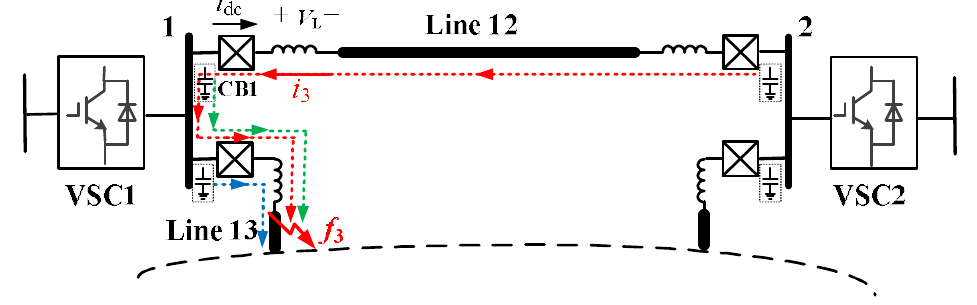
Figure 8. The voltage of inductor for the backward fault f 3 for CB1 in the multi-terminal system; i 3 suggests the fault current through local sensors at CB1.